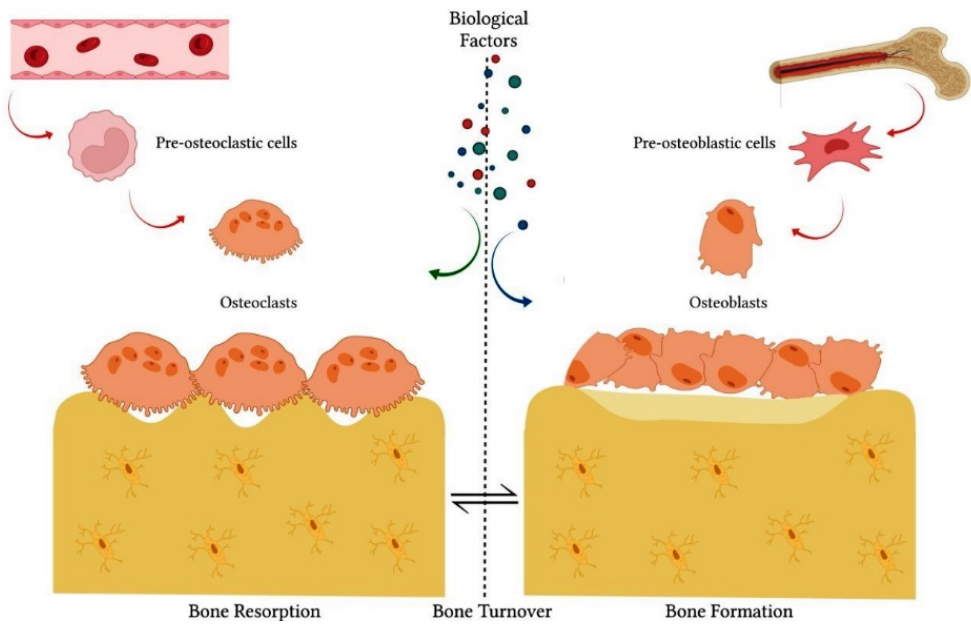
Figure 1. The integrity of bone tissue depends on the balance between bone formation and bone resorption processes. These processes are coordinated by the interactive action of specialized cells, such as osteoblasts and osteoclasts. Several biological factors also act in the process of physiological bone remodeling, such as cytokines, hormones, growth factors, transcriptional factors, ions and proteins of the extracellular matrix, in addition to other cell lines.